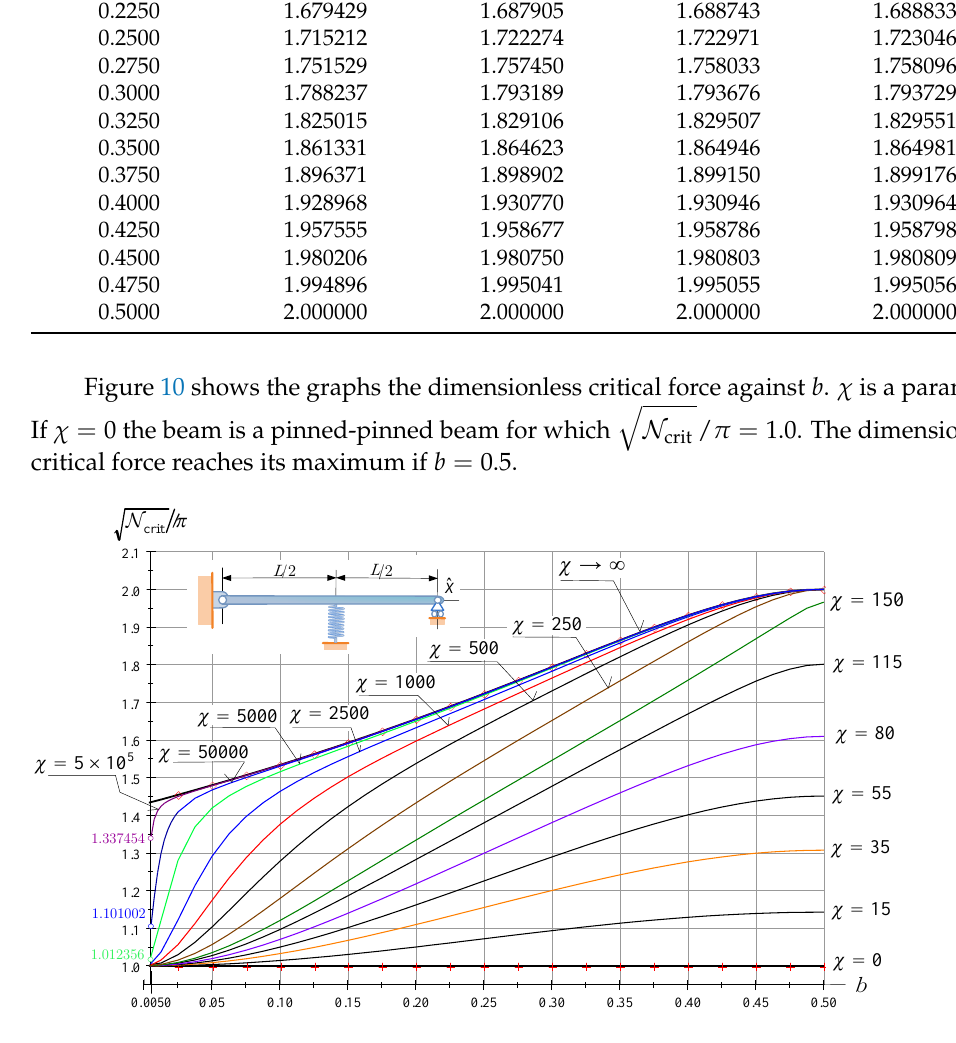
Figure 10. The dimensionless critical force of PssP beams as a function of b ; χ is a parameter. For χ → ∞ the curves representing the dimensionless critical forces in Figures 8–10 coincide with those curves presented in [32] for the dimensionless critical forces of FrF, FrP and PrP